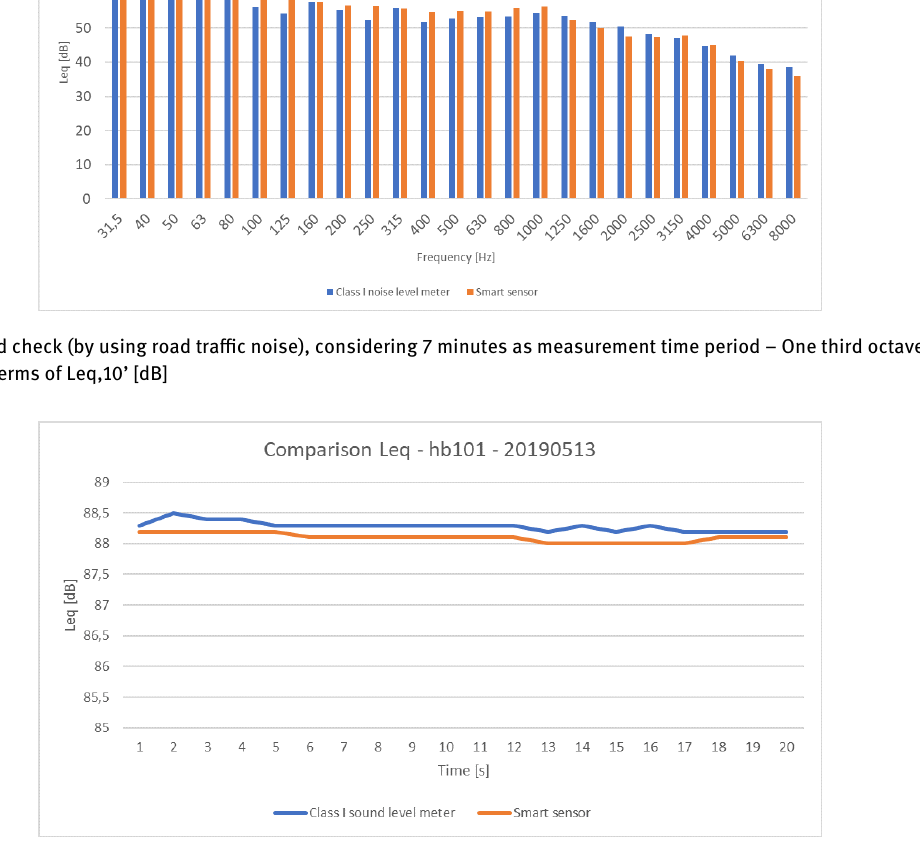
Figure 6: Broad band check (by using an electroacoustic source and a pink noise signal), considering 30 seconds as measurement time period – Time history of sound pressure levels, in terms of LAeq,1s [dB(A)]